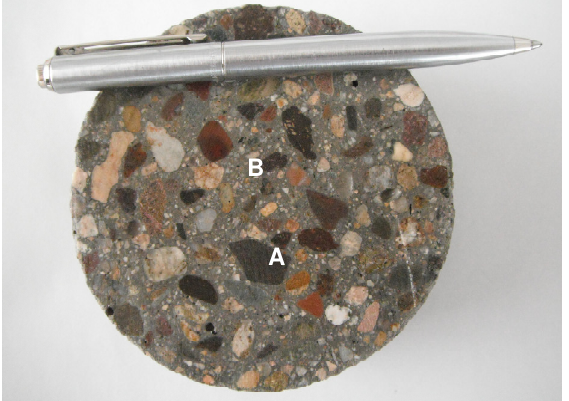
Figure 1. Piece of hydraulic concrete showing coarse aggregates ( Mortar is composed of cement